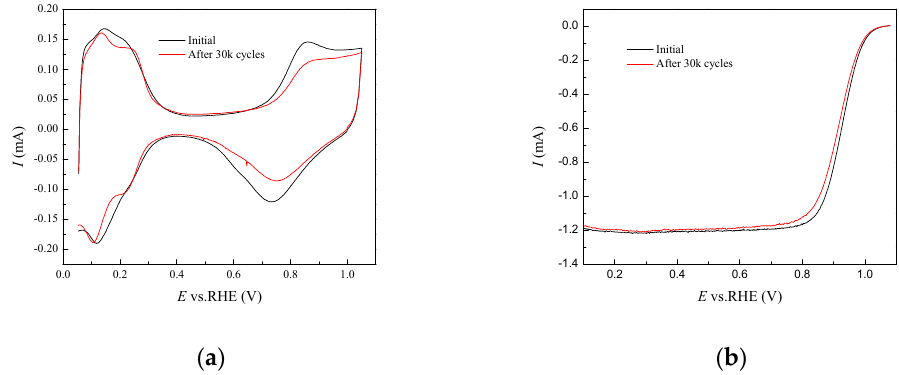
Figure 6. CV ( a ) and LSV ( b ) curves of PtNi/C before and after ADT.